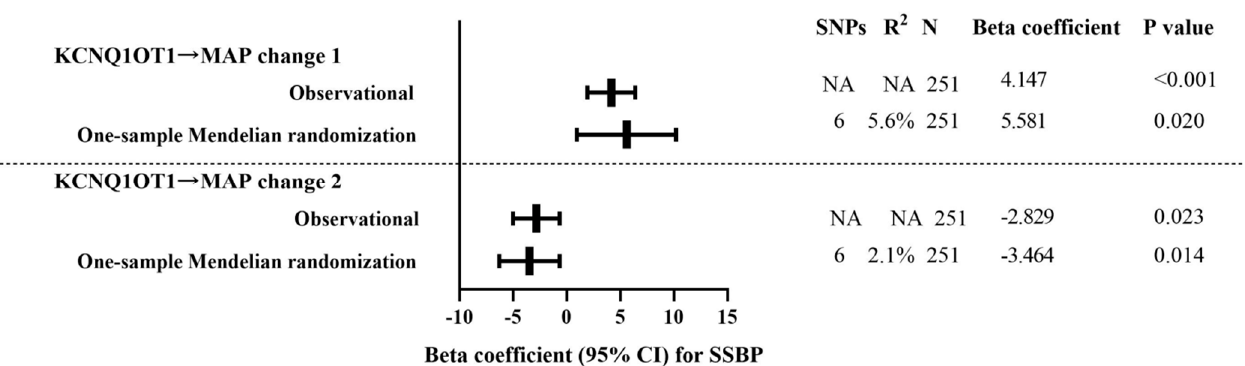
Figure 5. Association of observationally and genetically determined lncRNA KCNQ1OT1 and SSBP. Observational analyses used multiple linear regression multivariable adjusted for age and gender. One-sample Mendelian randomization analyses used instrumental variable analyses with two-stage least-squares regression.